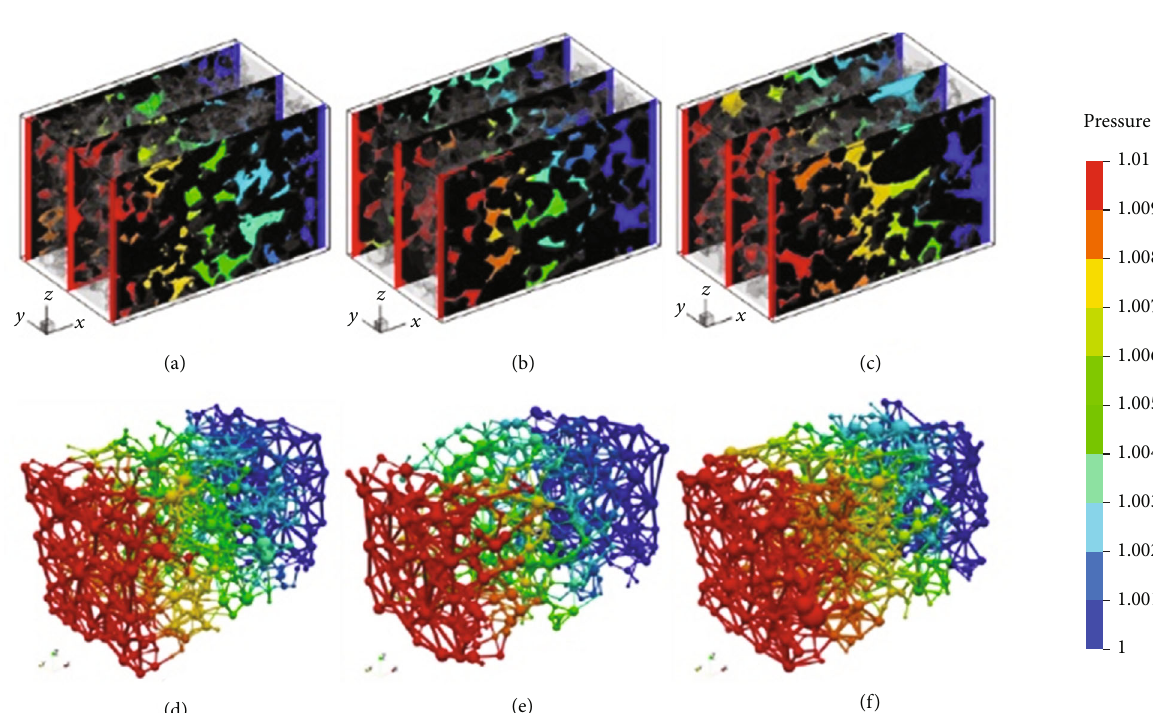
Figure 11: Dimensionless pressure distribution simulated by LBM direct simulation (top) and LBM-PNM (bottom) for di ff erent rocks [108]. Q 6 × Q base base